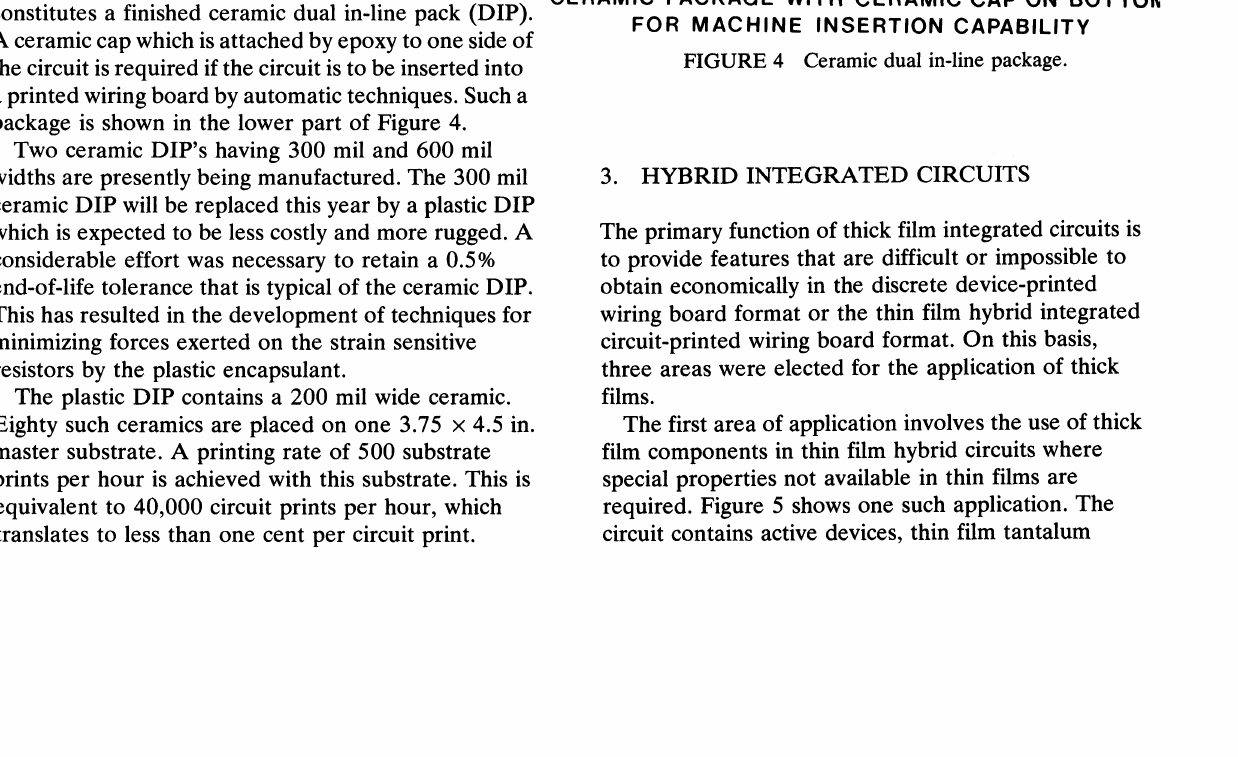
FIGURE 3 A 600 mil wide resistor network replicated 30 times on a 3.75 in. 4.5 in. 96% alumina ceramic.